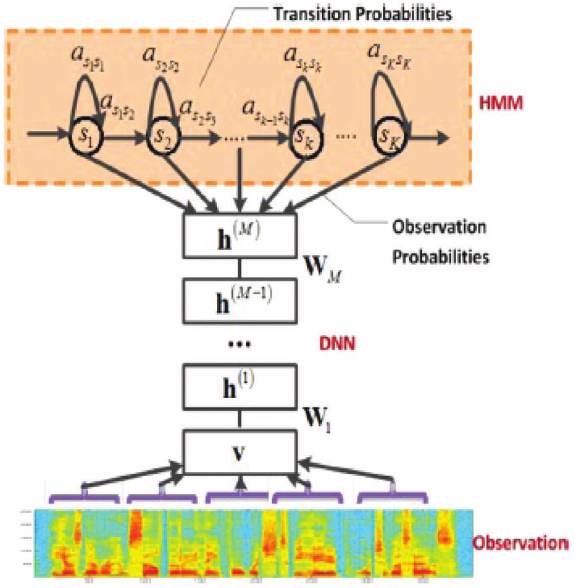
Figure 9: Block Diagram of Hybrid DNN and